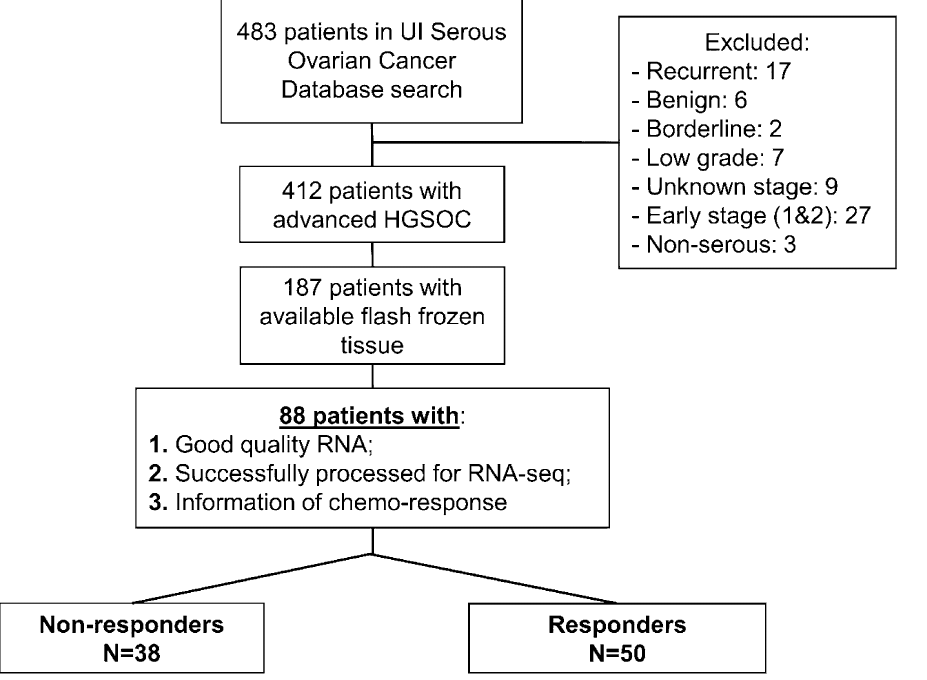
Figure 1. Selection criteria for patients in clinical prediction